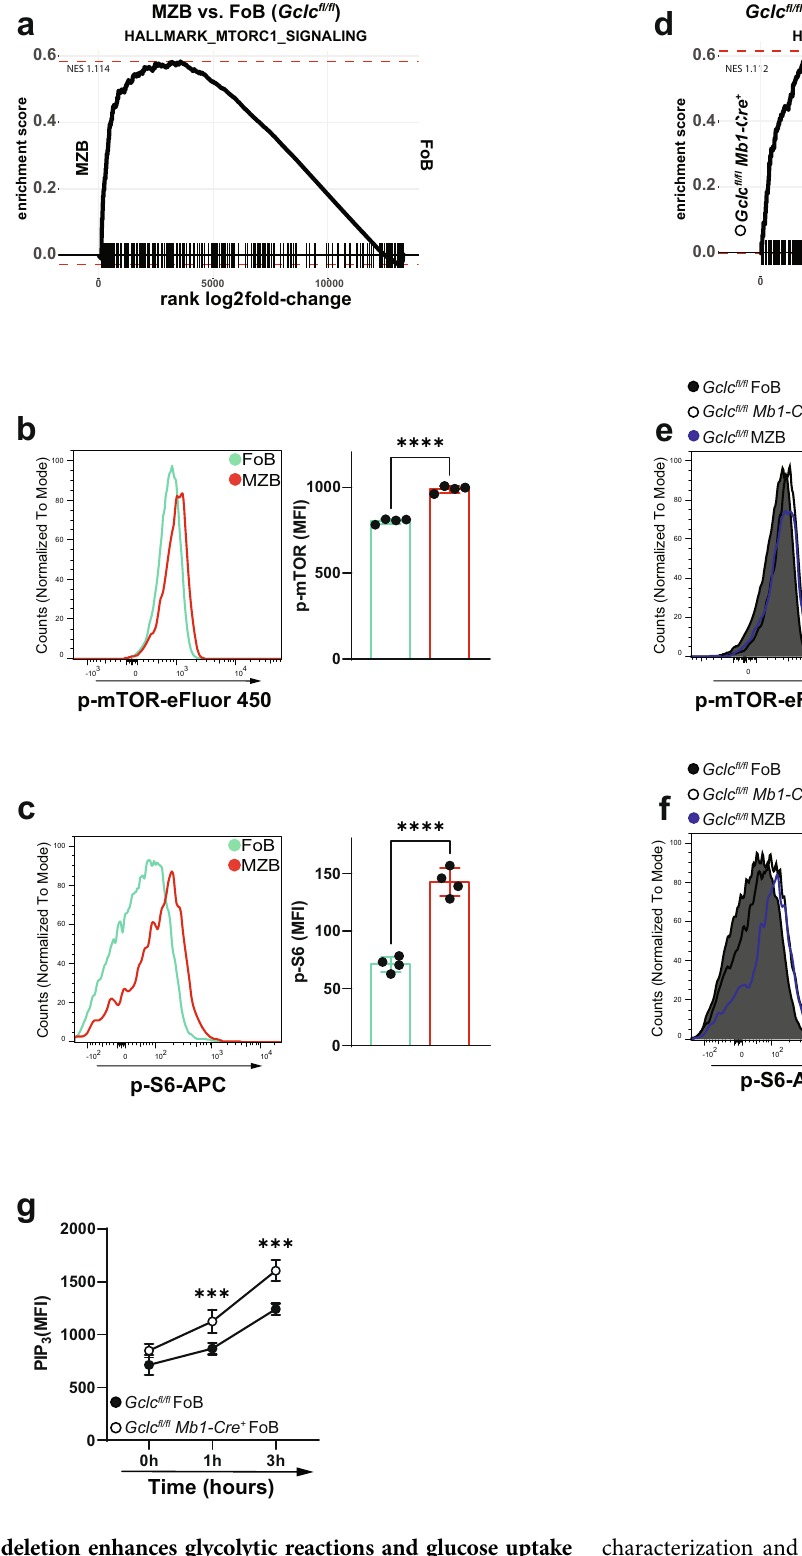
in FoB . mTORC1 signaling plays a role in maturation and acti- vation of both MZB and FoB 36 – 39 , and is key for the regulation of various metabolic pathways 34 . Therefore, in order to con- textualize the complexity of the metabolic network and the impact of Gclc on it, we analyzed our transcriptomic data using Compass, a fl ux balance analysis-based approach that allows the